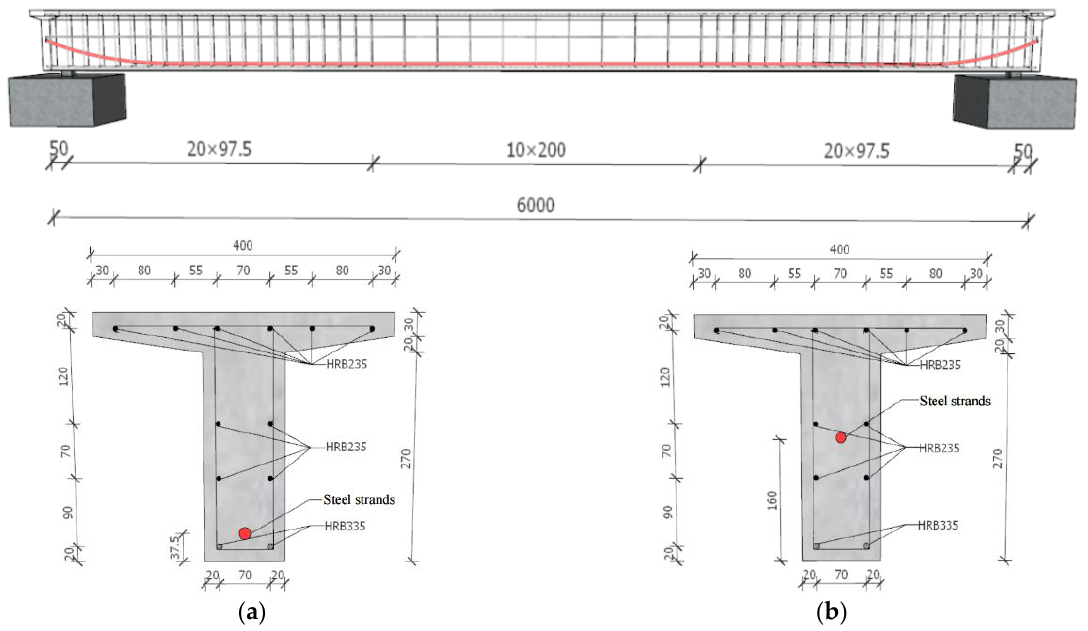
Figure 2. Size and reinforcement of T-beam (unit: mm): ( a ) mid-span section and ( b ) fulcrum cross- section.